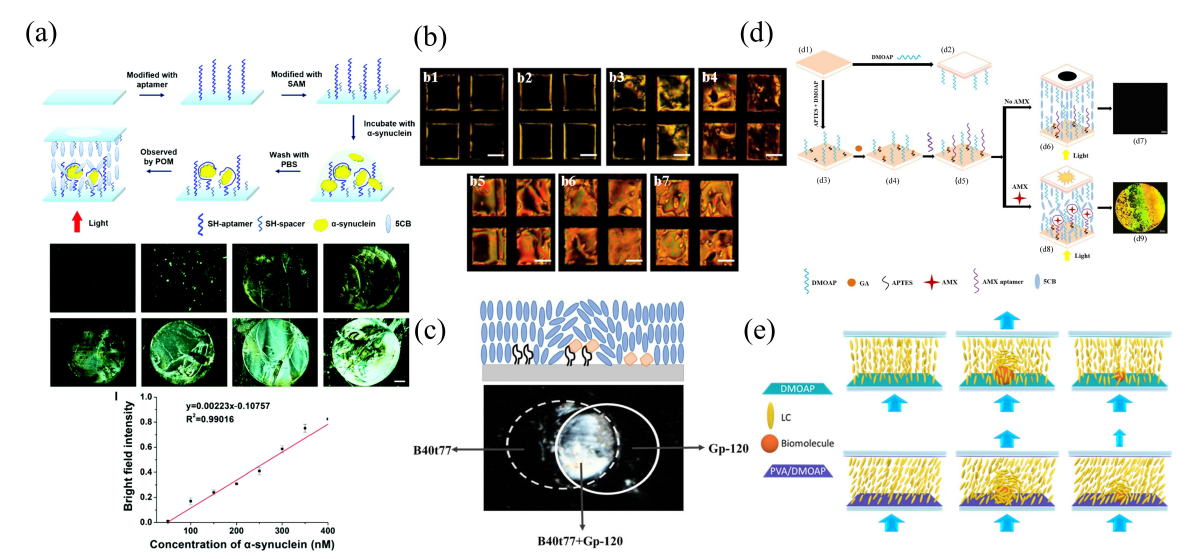
Figure 2. ( a ) Illustrations of the LC biosensor for the detection of α -syn and optical images of LC cells at different concentrations of α -syn [72]; reproduced with permission from Royal Society of